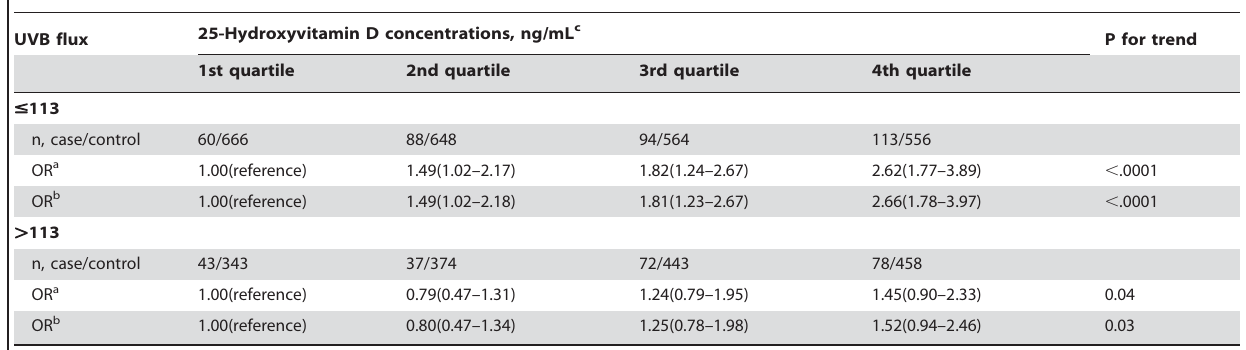
Table 5. Odds ratios of BCC by quartile of plasma vitamin D concentrations in NHS and NHS II (stratified by UVB flux).